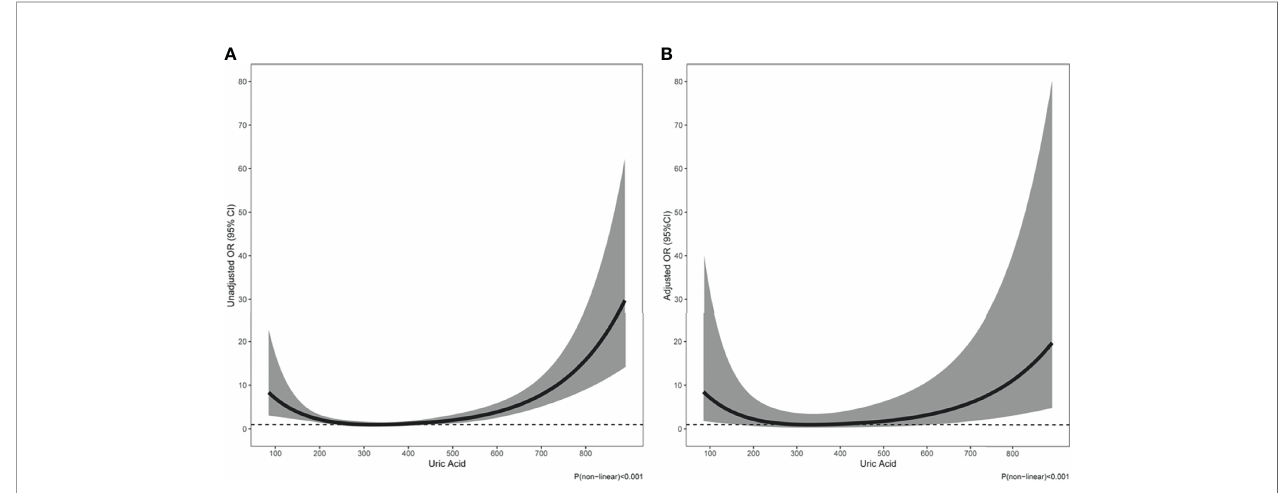
FIGURE 2 | The association of uric acid with in-hospital death (A) Unadjusted; (B)